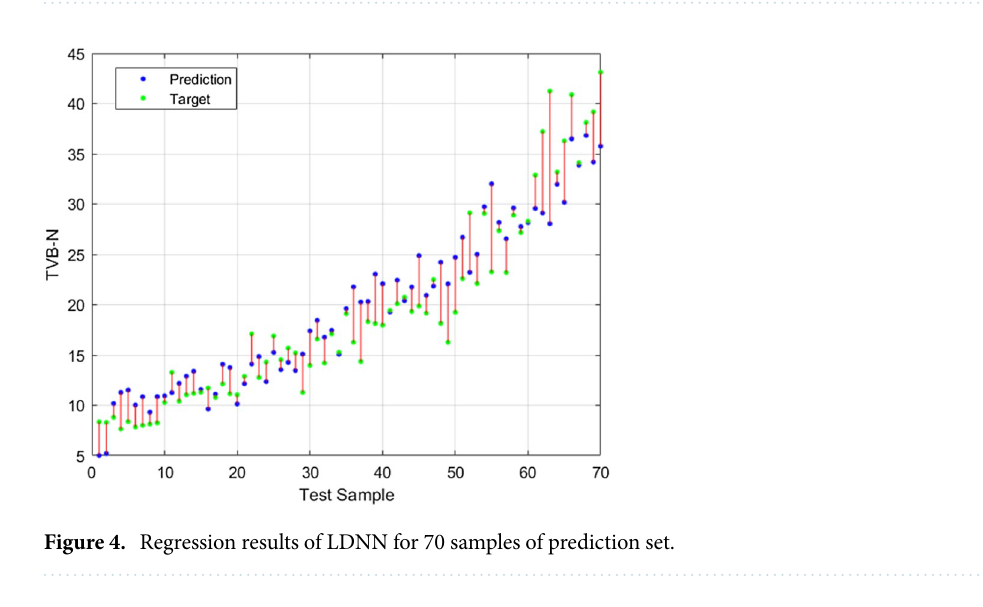
Figure 3. The effect of various chemometric models on (A) R 2 P ; (B) RMSEP; Similar small letters indicate non- significant difference between models ( p > 0.05).